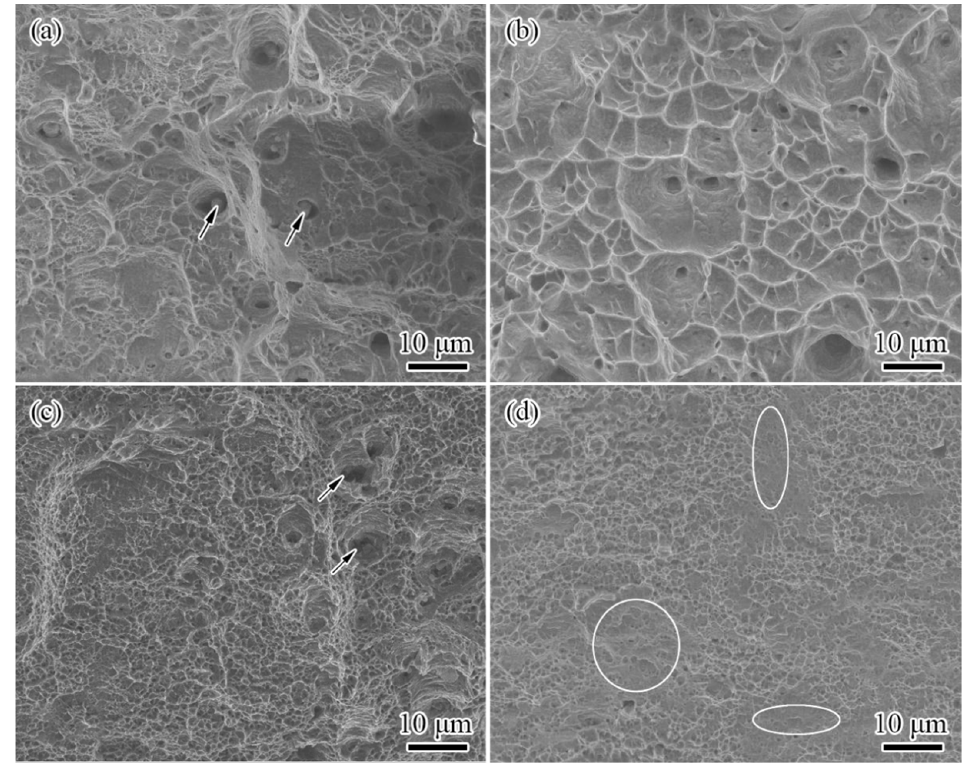
Figure 3. SEM images showing the tensile fracture surface features in Fe-19Cr-16Mn-2Mo-0.49N ( a , b ) and Fe-18Cr-16Mn-2Mo-0.85N ( c , d ) steels at the strain rates of 10 − 4 s − 1 ( a , c ) and 10 − 2 s − 1 ( b , d ).